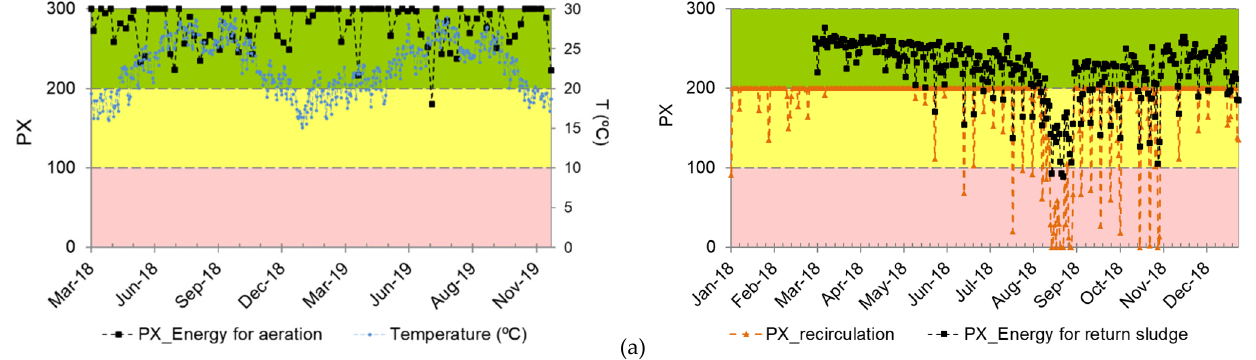
Figure 12. The performance indices of energy for aeration and temperature ( a ), and the performance indices of the return sludge and of the associated unit energy( b ), over the period analyzed in WWTP